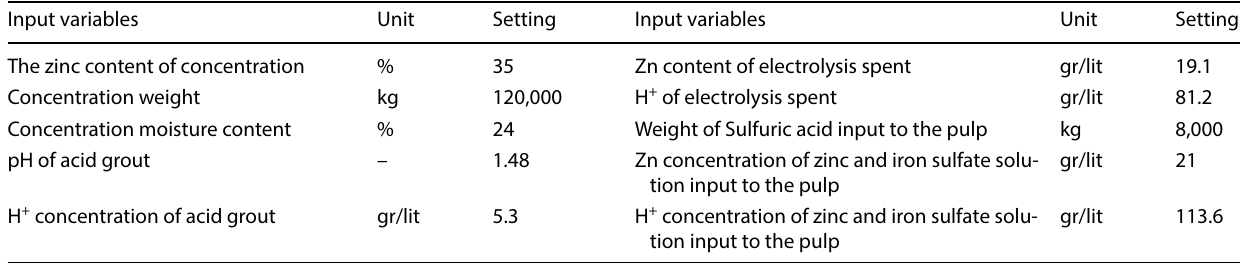
Table 11 Inputs setting for the first